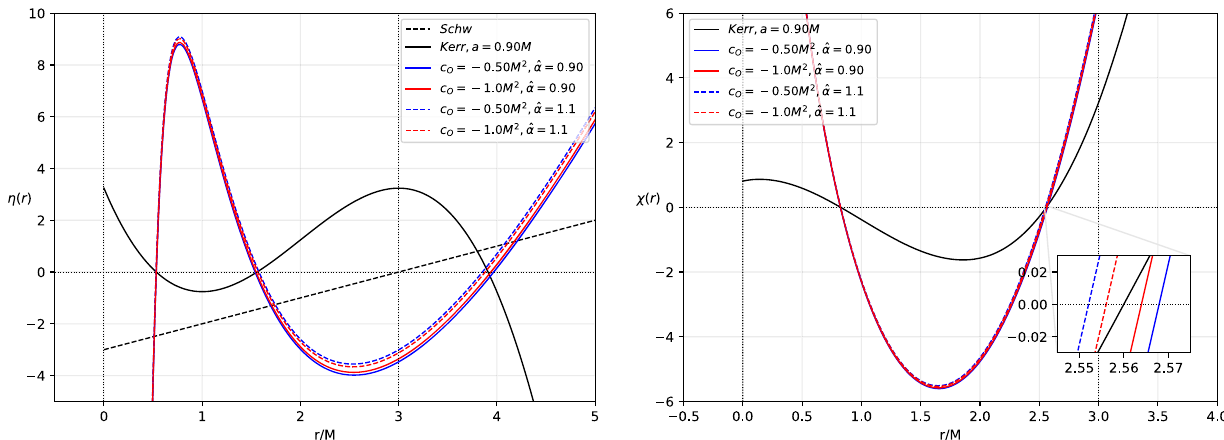
Fig. 2 Location of the photonsphere (left panel), and location of the photonsphere crossing at φ = 0 or along the equatorial plane (right panel). We take a = 0 . 90 M in both plots ( a is the black hole spin parameter)